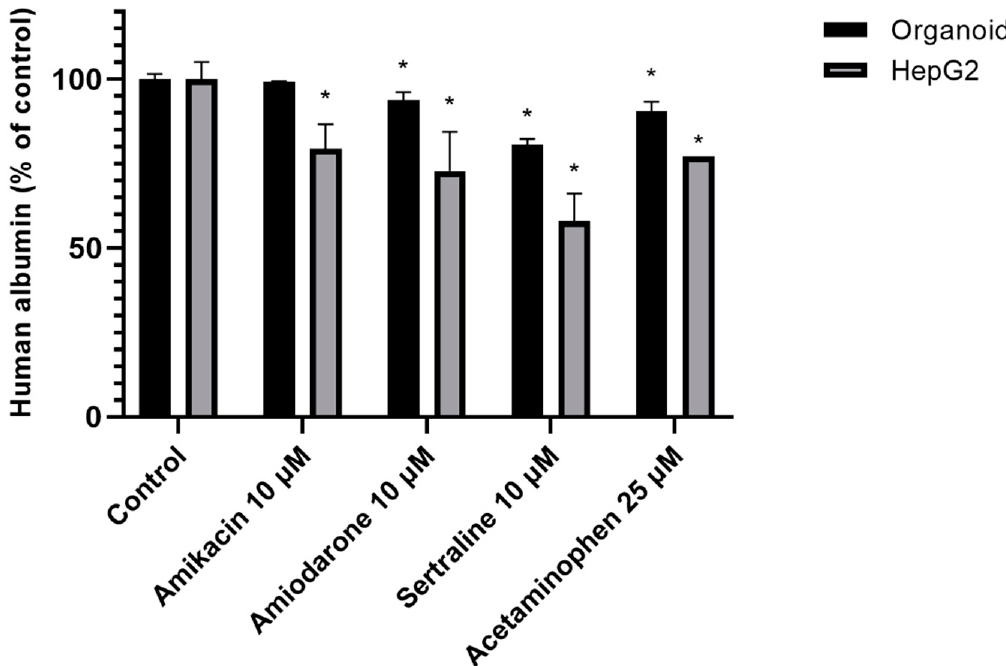
Figure 6. Secreted albumin levels from organoids and HepG2 cells. Organoids and HepG2 cells were incubated with the indicated drugs (10 µ M amikacin, amiodarone, sertraline, and 25 µ M acetaminophen) for 48 h. A non-treatment group was used as a control. Data are shown as a mean ± standard error; * p < 0.05. The experiments were performed in duplicate, each being repeated at least three times.